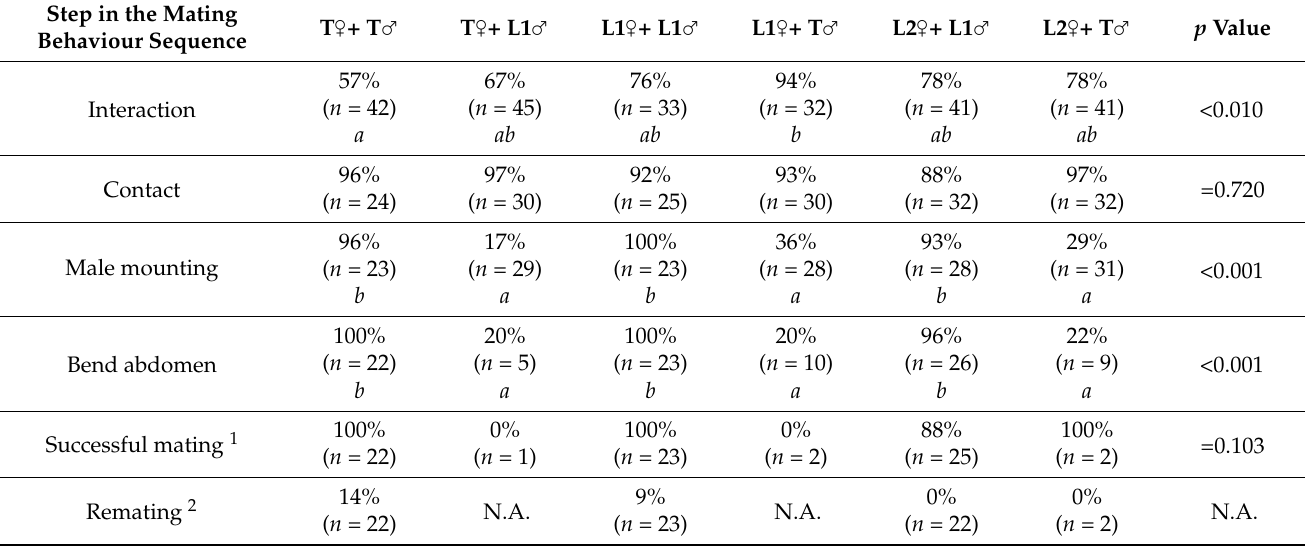
Table 4. The percentage of pairs that completed each step in the mating behaviour sequence as a proportion of those ( n ) that completed the previous step.